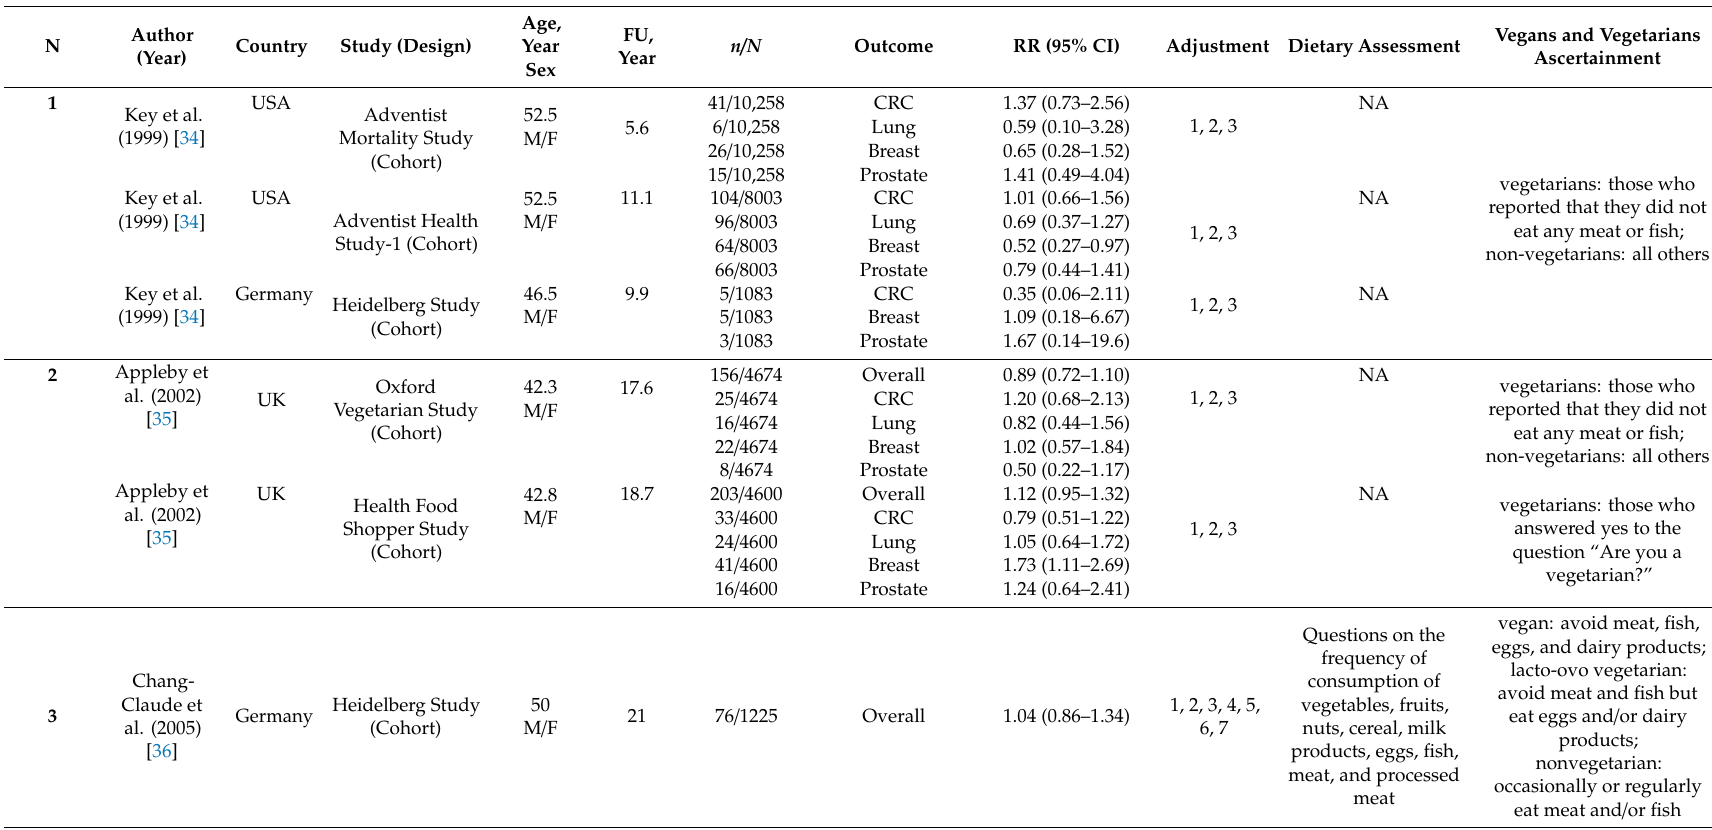
Table 1. Characteristics of the studies evaluating VD (vs. nonvegetarian diet) and cancer mortality including cause-specific cancer